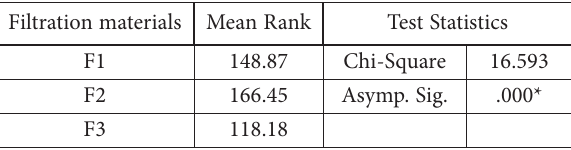
Note : *Significant at p = 0.05.